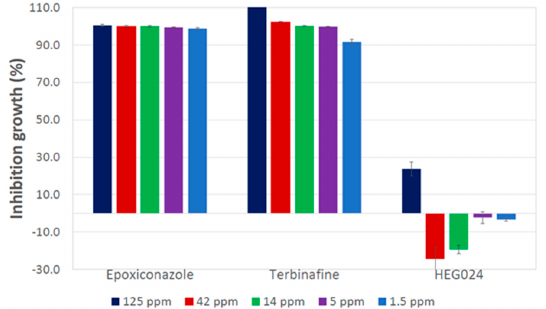
activity compared with Epoxiconazole and Terbinafine.